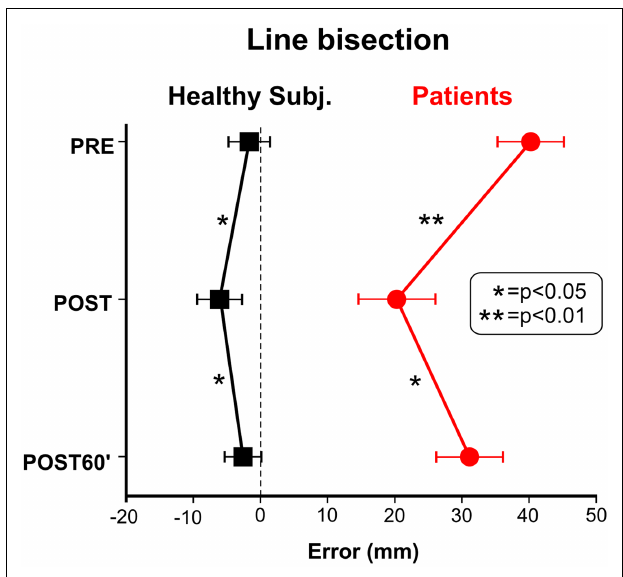
FIGURE 2 | Effect ofTENS on line bisection performance of healthy subjects and neglect patients . Positive values indicate a rightward shift of the subjective